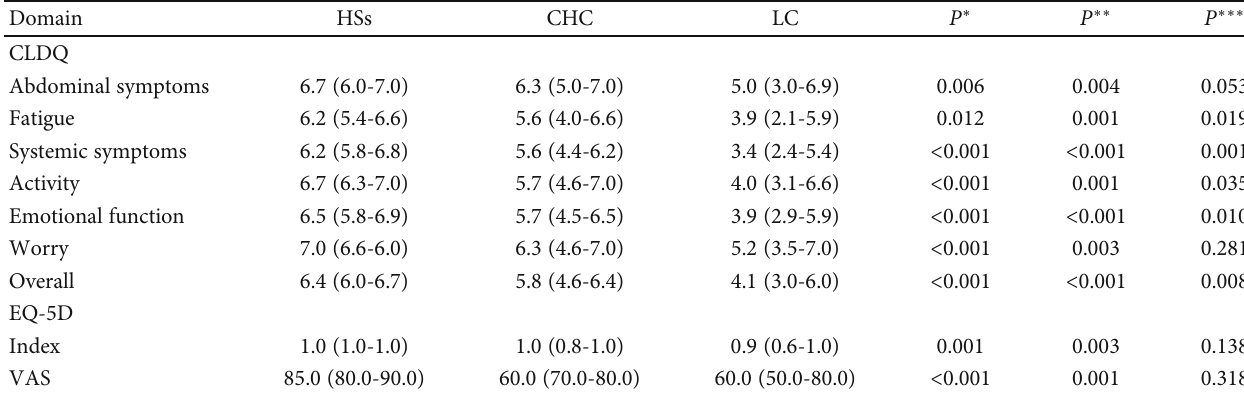
Table 2: CLDQ and EQ-5D scores among patients with CHC, LC, and healthy subjects.